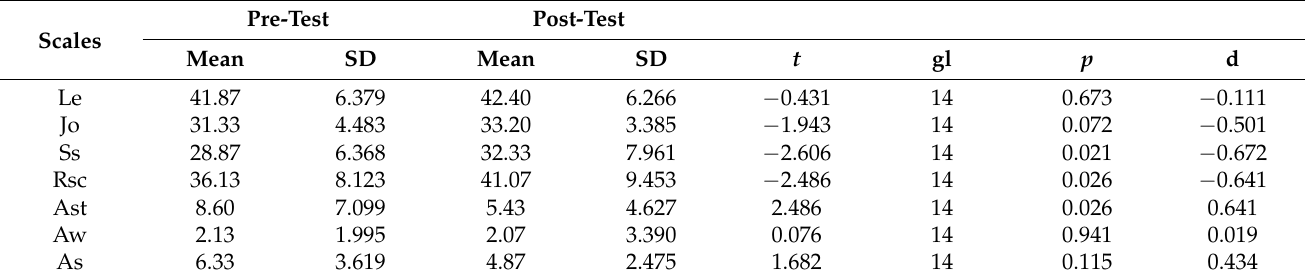
Table 5. Scores obtained in the parents’ BAS at the beginning and end of the second grade of primary school.